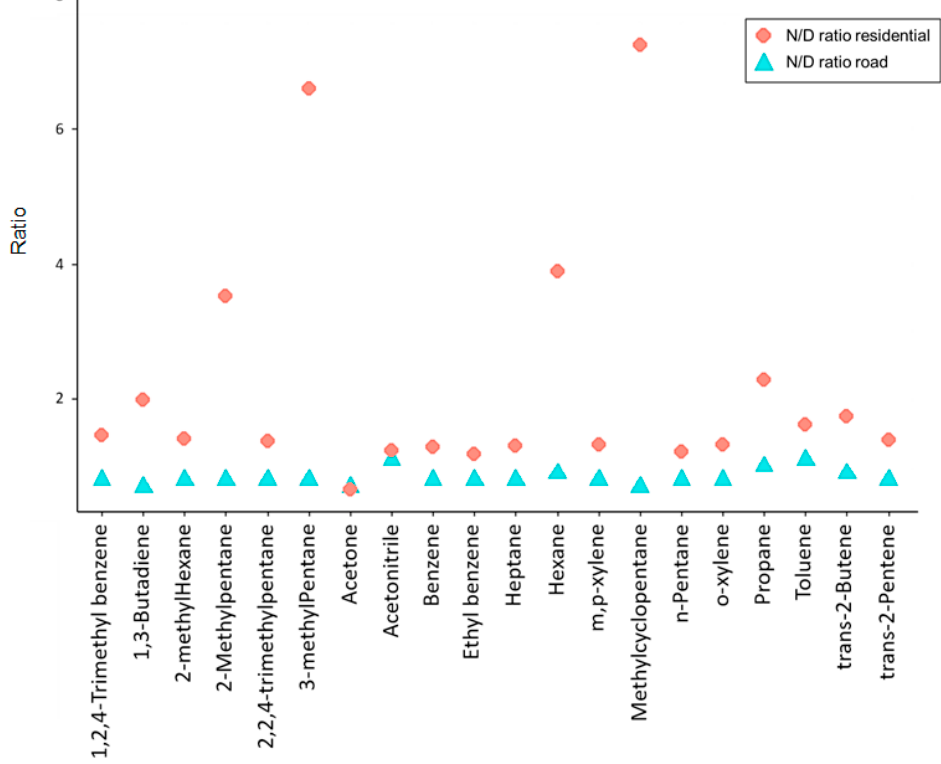
Figure 5. VOC species concentration ratios of nighttime and daytime at roadside and residential sites.